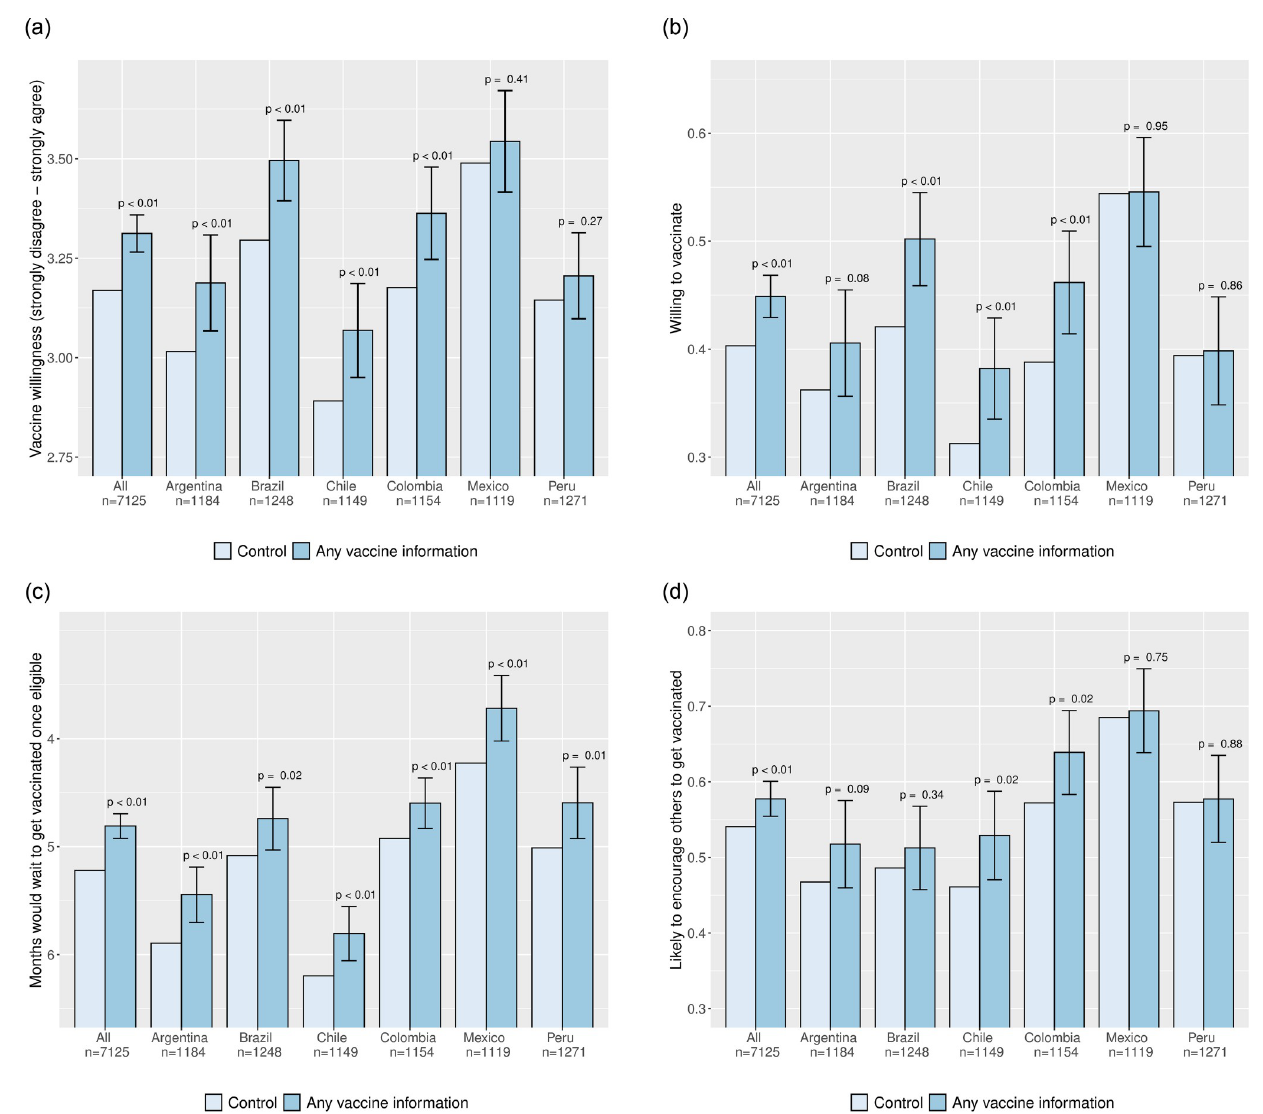
Fig 4. Average effects of any vaccine information treatment on vaccine willingness, by country. Each bar depicts a group outcome mean. The outcome in panel (a) is a five-point vaccine willingness scale ranging from “strongly disagree” (1) to “strongly agree” (5); the outcome in panel (b) is an indicator for “agree” or “strongly agree”; the outcome in panel (c) is the (reversed) number of months that a respondent would wait to get vaccinated once eligible for a vaccine; and the outcome in panel (d) is an indicator for a respondent being “somewhat likely” or “very likely” to encourage others to get vaccinated. Error bars denote 95% confidence intervals for treatment effects relative to the control group; the associated p values are from two-sided t tests. The underlying regression specifications for each outcome are described in S3 Appendix and the underlying regression table is reported in S6 Appendix.